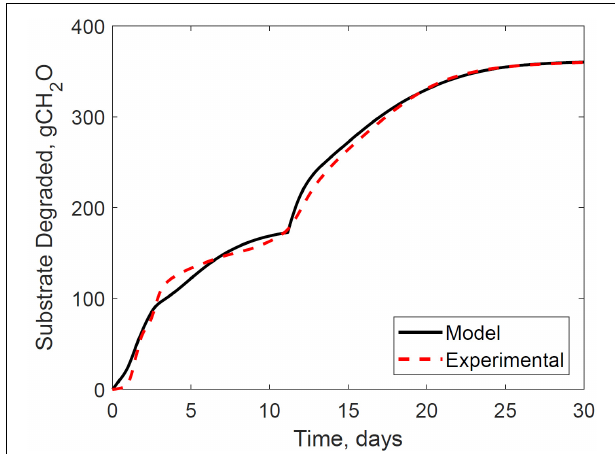
FIGURE 4 | Reactor 2 substrate degraded calibration of system dynamics model. The model inputs are 347 cc.min − 1 airflow rates, 30% initial moisture content, 17% final moisture content, 24 ◦ C ambient temperature. The initial model condition is 7080 g. The relative error is 2.0%.